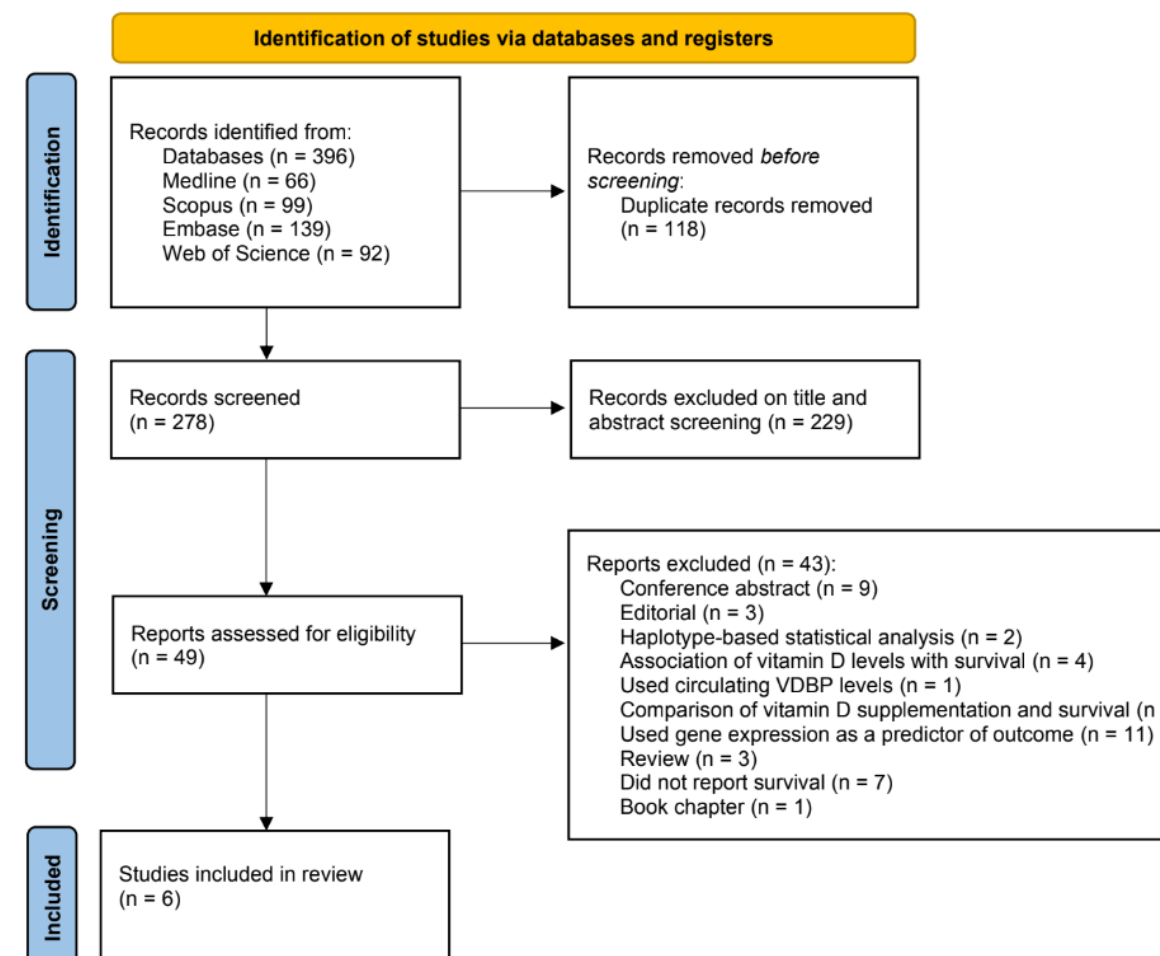
Figure 2. Systematic review study selection PRISMA flow diagram.